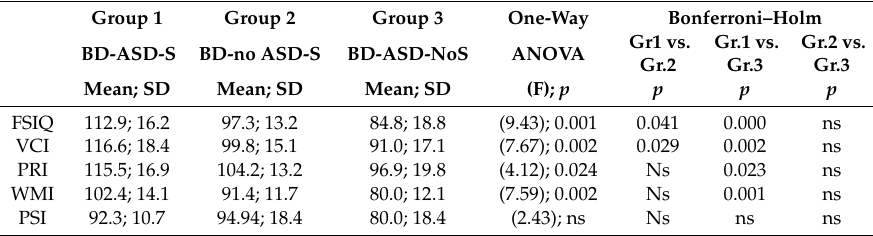
Table 1. Wechsler Intelligence Scale for Children—Fourth Edition (WISC-IV) (Wechsler, 2003). Comparisons among groups. Legenda; BD-ASD-S = Bipolar Disorder + High Functioning Autism Spectrum Disorder + Severe Suicide Ideation or Attempt; BD-noASD-S = Bipolar Disorder + Severe Suicide Ideation or Attempt, without High Functioning Autism Spectrum Disorder; BD-ASD-noS = Bipolar Disorder + High Functioning Autism Spectrum Disorder, without Severe Suicide Ideation or Attempt; SD: Standard Deviations; FSIQ: Total Intellectual Quotient; VCI: Verbal Comprehension Index; PRI: Perceptual Reasoning Index; WMI: Working Memory Index; PSI: Processing Speed Index. Statistical significance at p < 0.05.